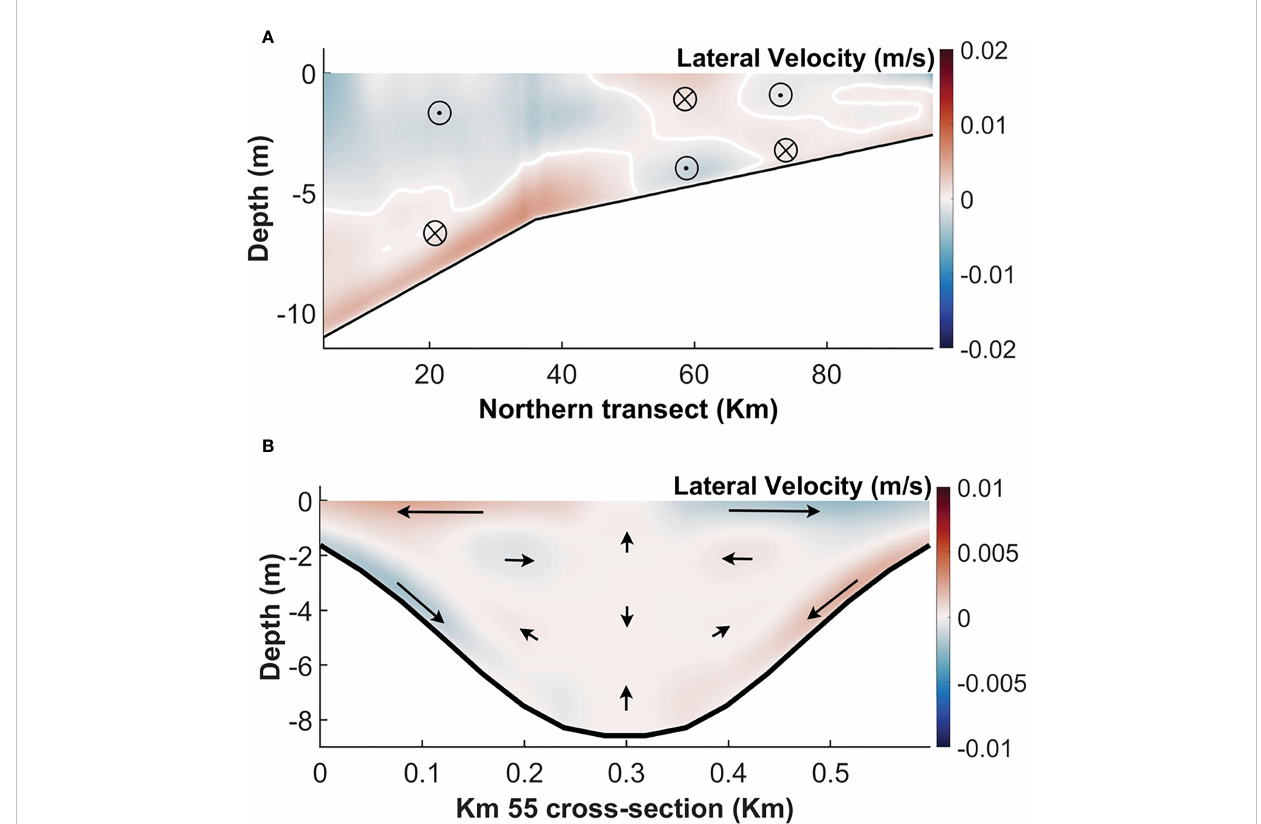
FIGURE 5 Time-averaged lateral velocities (A) along the northern transects shown in Figure 1, and (B) along the cross section at 55 km from the mouth in EXP1. Red and blue colors in (A) represent northward and southward velocities, respectively. Leftward and rightward velocities looking into the estuary are identi fi ed in (B) by red and blue colors,